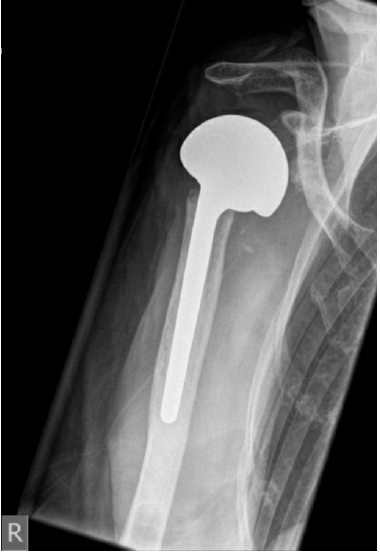
Figure 3. Postoperative anterior–posterior X-ray imaging of a right shoulder after prosthesis reim- plantation of hemiarthroplasty with large head (CTA head) due to severe glenoid defect.